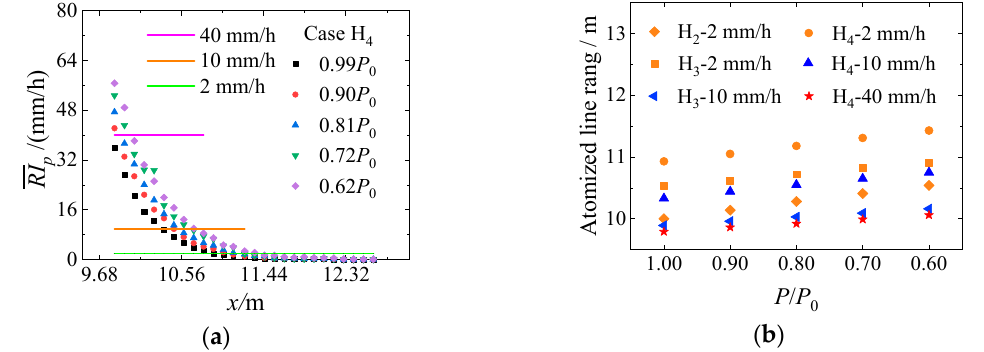
Figure 5. Range of characteristic rain intensity lines affected by low ambient pressure. ( a ) Fitting Figure 5. Rangeofcharacteristicrainintensitylinesaffectedbylowambientpressure. ( a )Fittingcalculation of case H4; ( b ) Atomized line range of Case H 2 ~H 4 ; Case H 2 with Q = 120.00 m 3 / h and V = 11.11 m / s, calculation of case H4; ( b ) Atomized line range of Case H 2 ~ H 4 ; Case H 2 with Case H 3 with Q = 125.00 m 3 / h and V = 11.57 m / s, Case H 4 with Q = 130.00 m 3 / h and V = 12.04 m / Q = 11.11 m/s, Case H 3 with = 125.00 m 3 /h and V = 11.57 m/s, Case H 4 with 12.04 m/s.